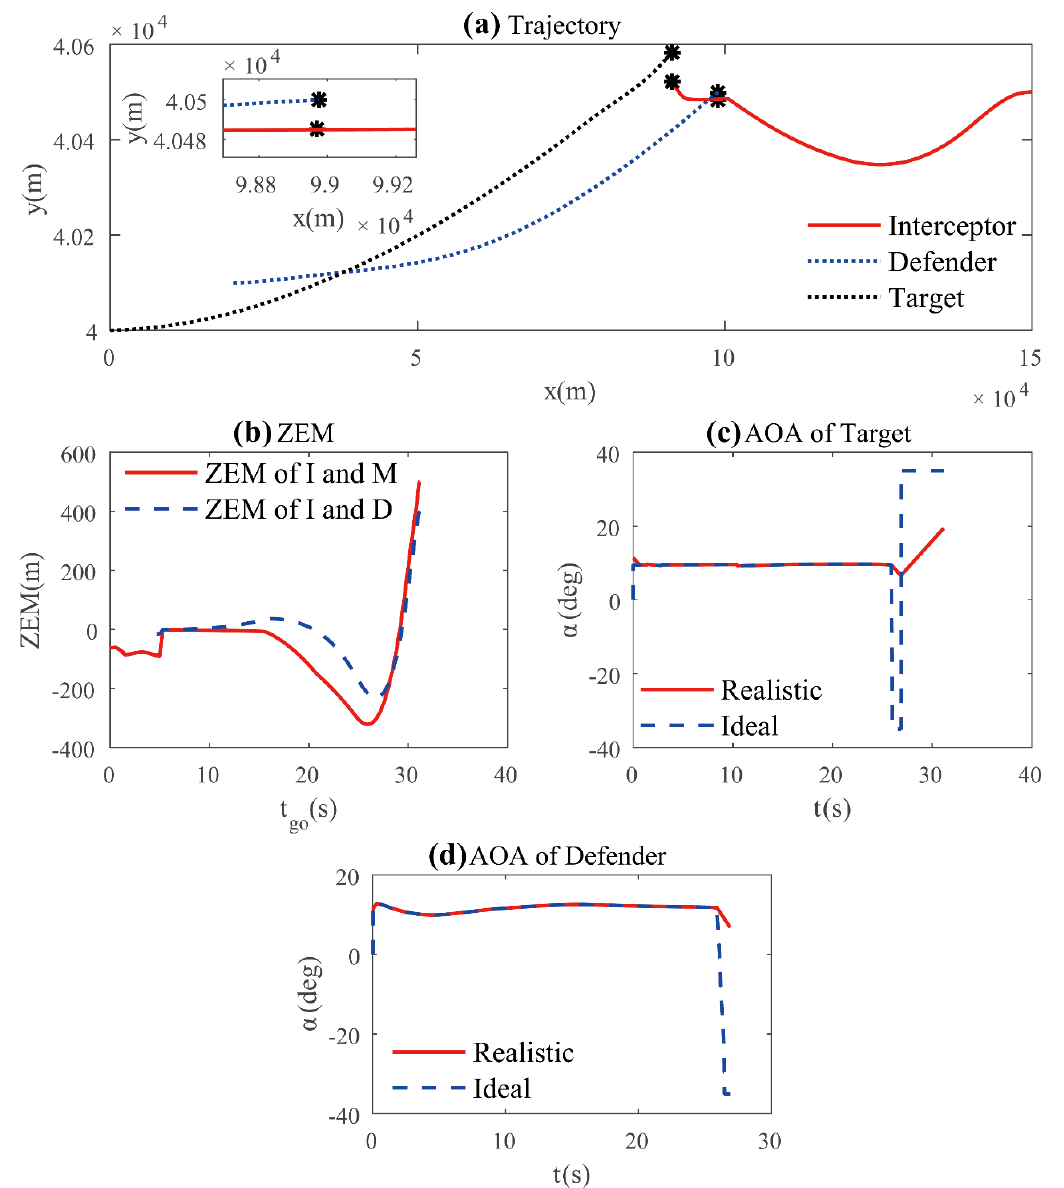
Figure 4. Simulation results of Case 2: ( a ) trajectory; ( b ) ZEM; ( c ) target’s AOA; ( d ) defender’s AOA. Case 3. The performance of guidance strategies in engagement, LQOGLvLQOGLvLQOGL, is investigated in this case. LQOGLs for three adversaries are calculated through Equations (45), (53), (55), and (56). Weight parameters are chosen as follows: